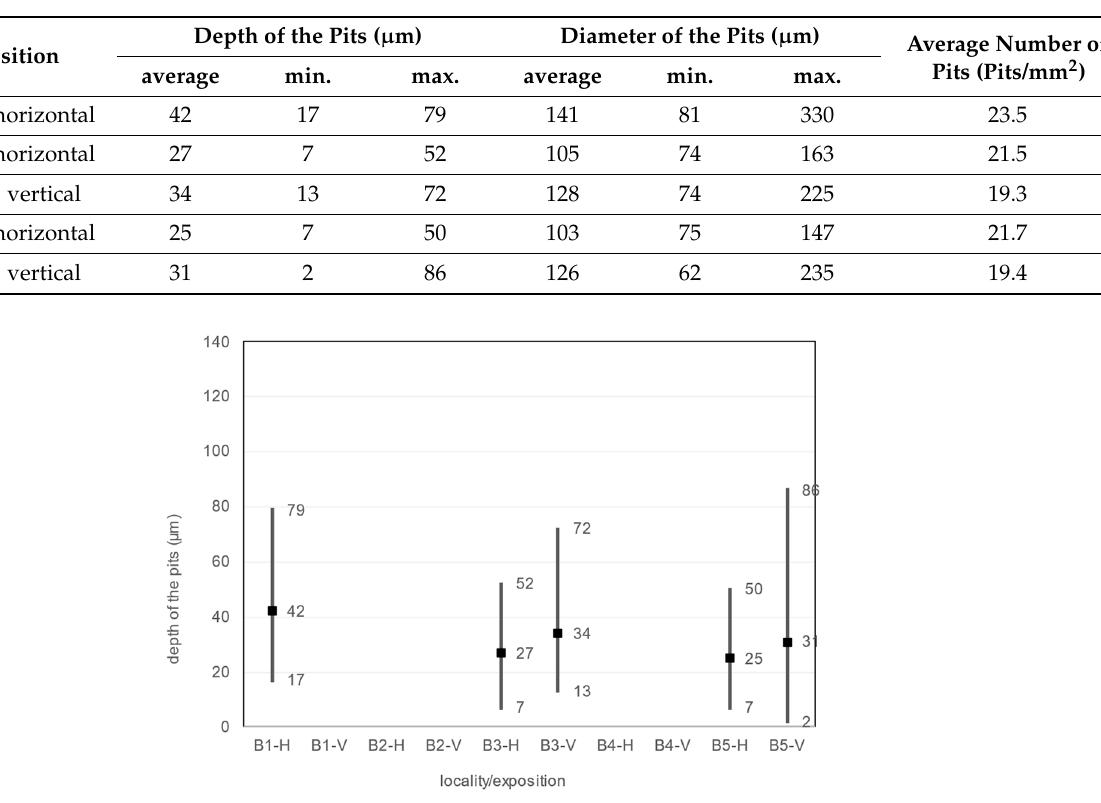
Table 29. Depth of the pits, diameter of the pits, average number of pits.